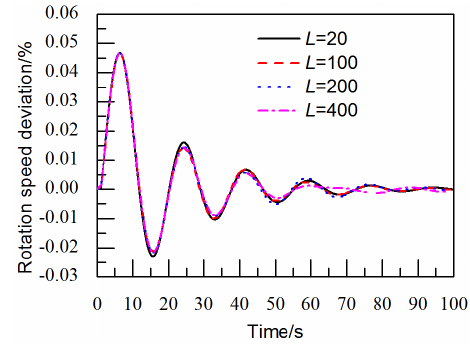
Figure 5. The influence of an open channel length (m) on the unit rotation speed.